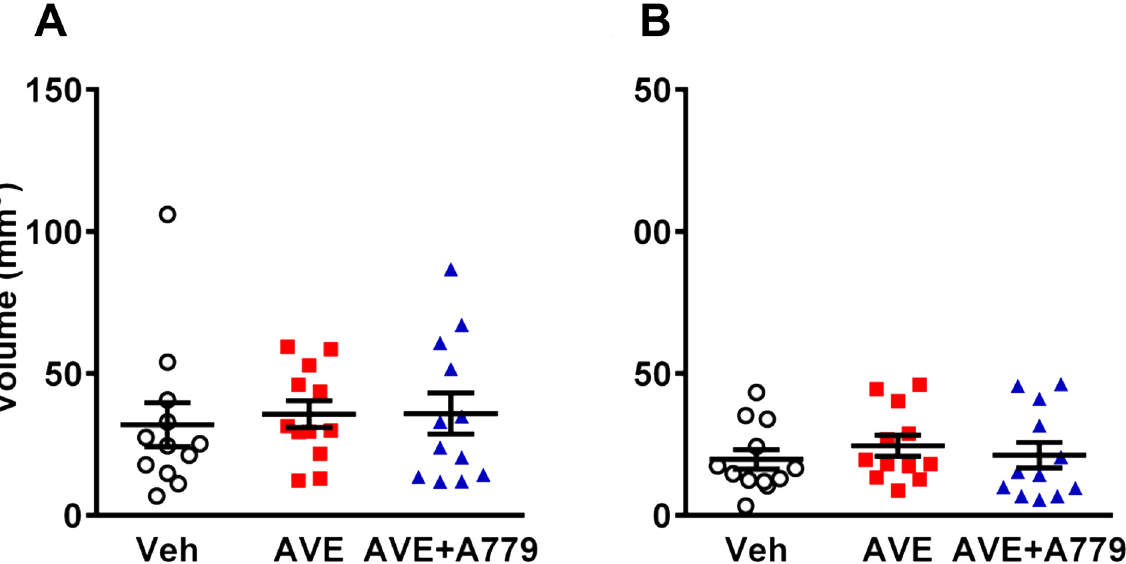
Fig 4. Cerebral infarct and edema volumes. Infarct volumes taken 24 h post-transient middle cerebral artery occlusion in (A) total infarct and (B) edema volumes (vehicle, n = 12; AVE0991, n = 12; AVE0991+A779, n = 12). Data are presented as mean ± S.E.M.